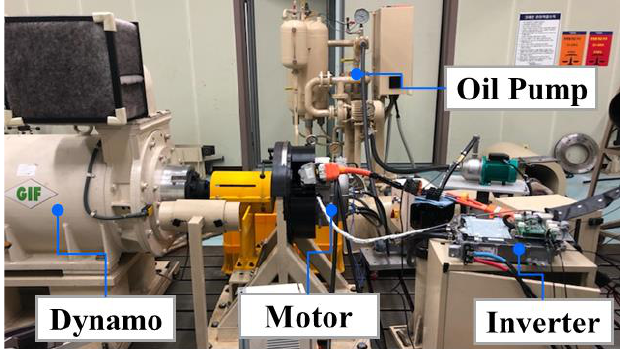
Figure 7. Experimental setup.